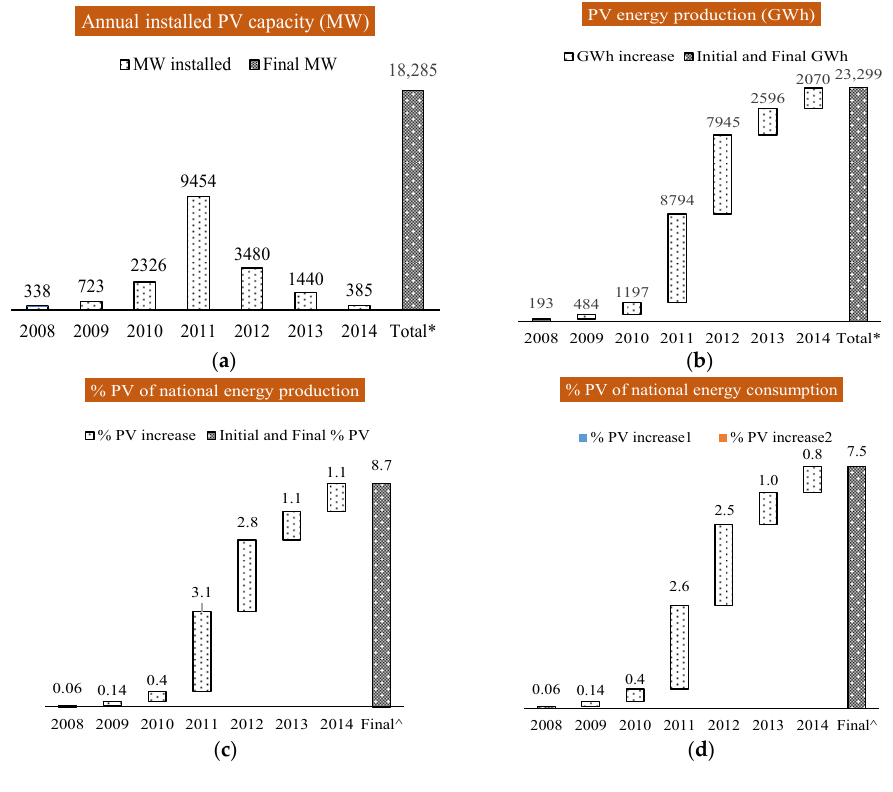
Figure 1. The growth of photovoltaic (PV) in Italy (2008–2014) Source: [25]. * = Cumulative value (<2008–2014); ^ = Specific value (2014).